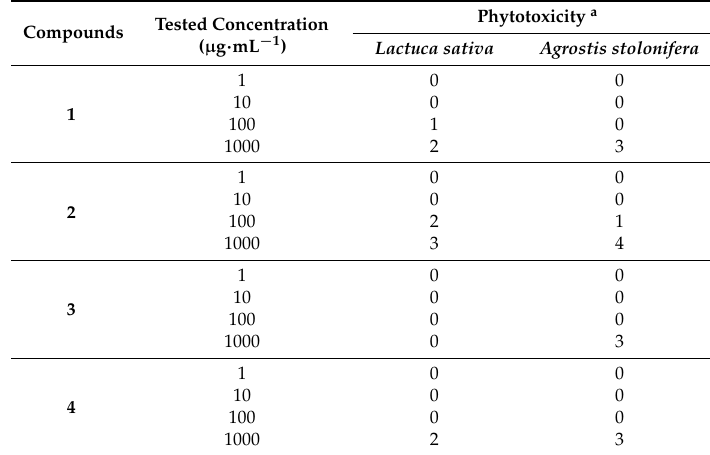
Table 1. Herbicidal activity of pure compounds isolated from adventitious roots of Vellozia gigantean